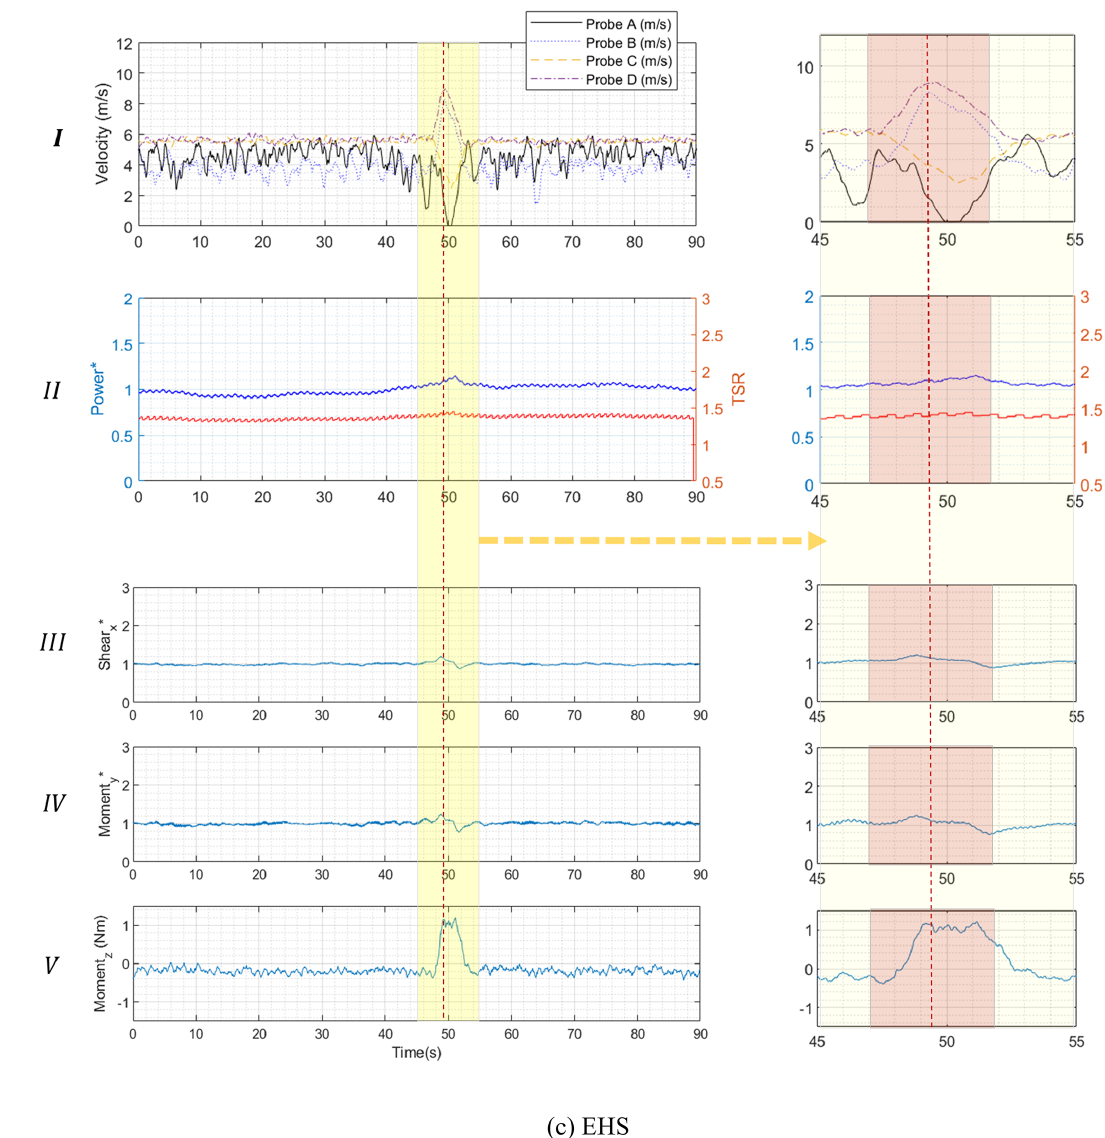
Figure 6. The time history of the results from all the measuring instruments in (a) the EVS and (b) the negative EVS. Windows I, II, III and IV from top to bottom in each panel show the wind velocities from four cobra probes, the power performance of the turbine, the X shear and the Y moment at the base of the tower respectively. Panel (c) is for the EHS and has an additional window V that reports the Z moment. The starred axis indexes are normalized by their corresponding value from uniform case A. The 10s window around the extreme events has been magnified and replotted at the right side of each panel with a red 5s window highlighting the theoretical duration of the extreme event and the red dashed line assumed as the centre of the events which passes through the first velocity